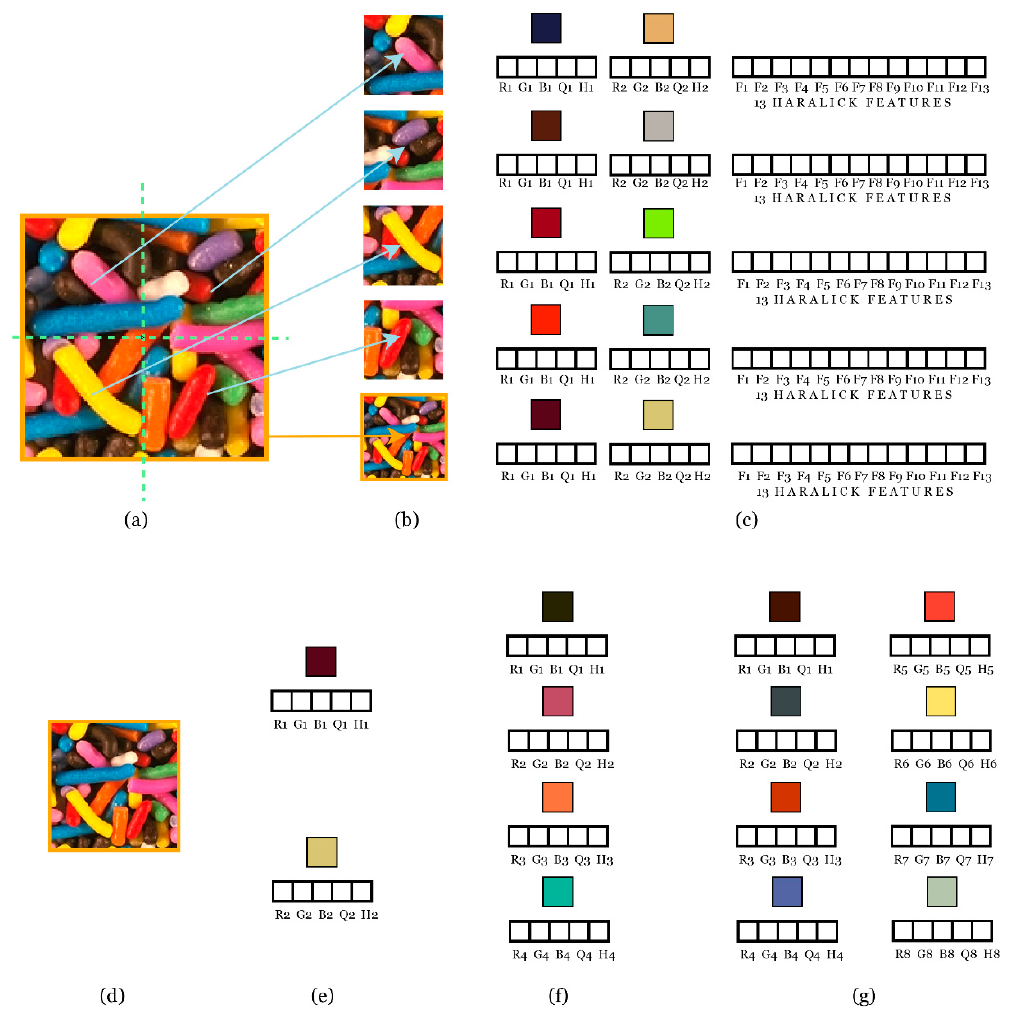
Figure 8. Feature vector extracted from one image of the Vistex Database (Food0007). ( a ) The original image is divided into five partitions ( b ): four local partitions and one global (the same image, bottom). ( c ) The feature vectors obtained from each partition. The color feature vectors and texture feature vectors are concatenated. ( d – g ) The global sub-image as a real example using one iteration ( e ), two iterations ( f ), or three iterations ( g ) of the BQMP method.